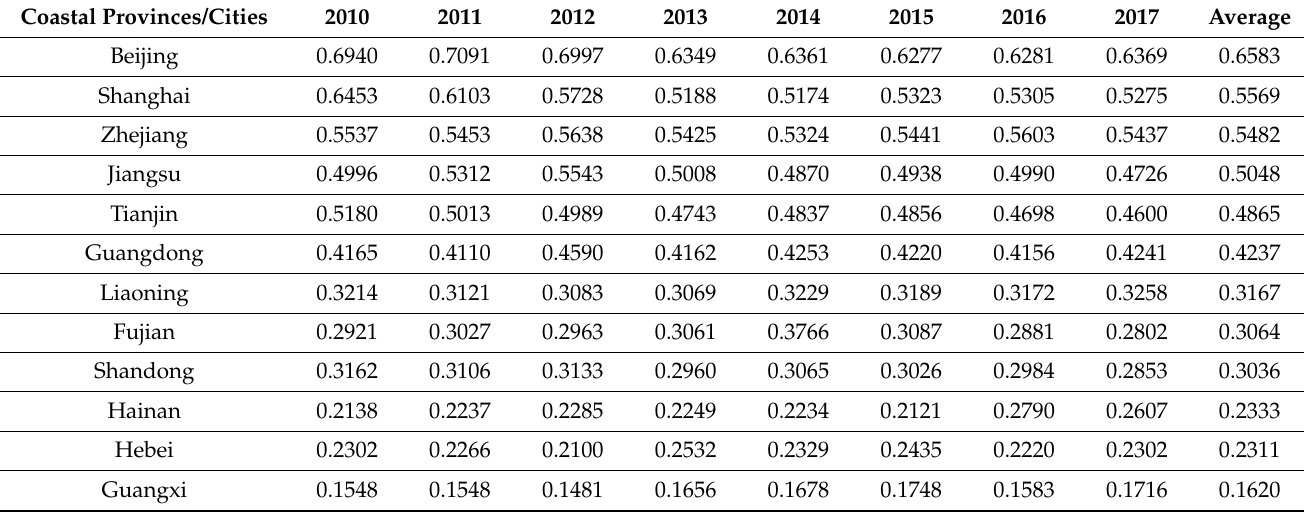
Table 3. The closeness degree of public service quality in 12 coastal provinces and cities of China. Coastal